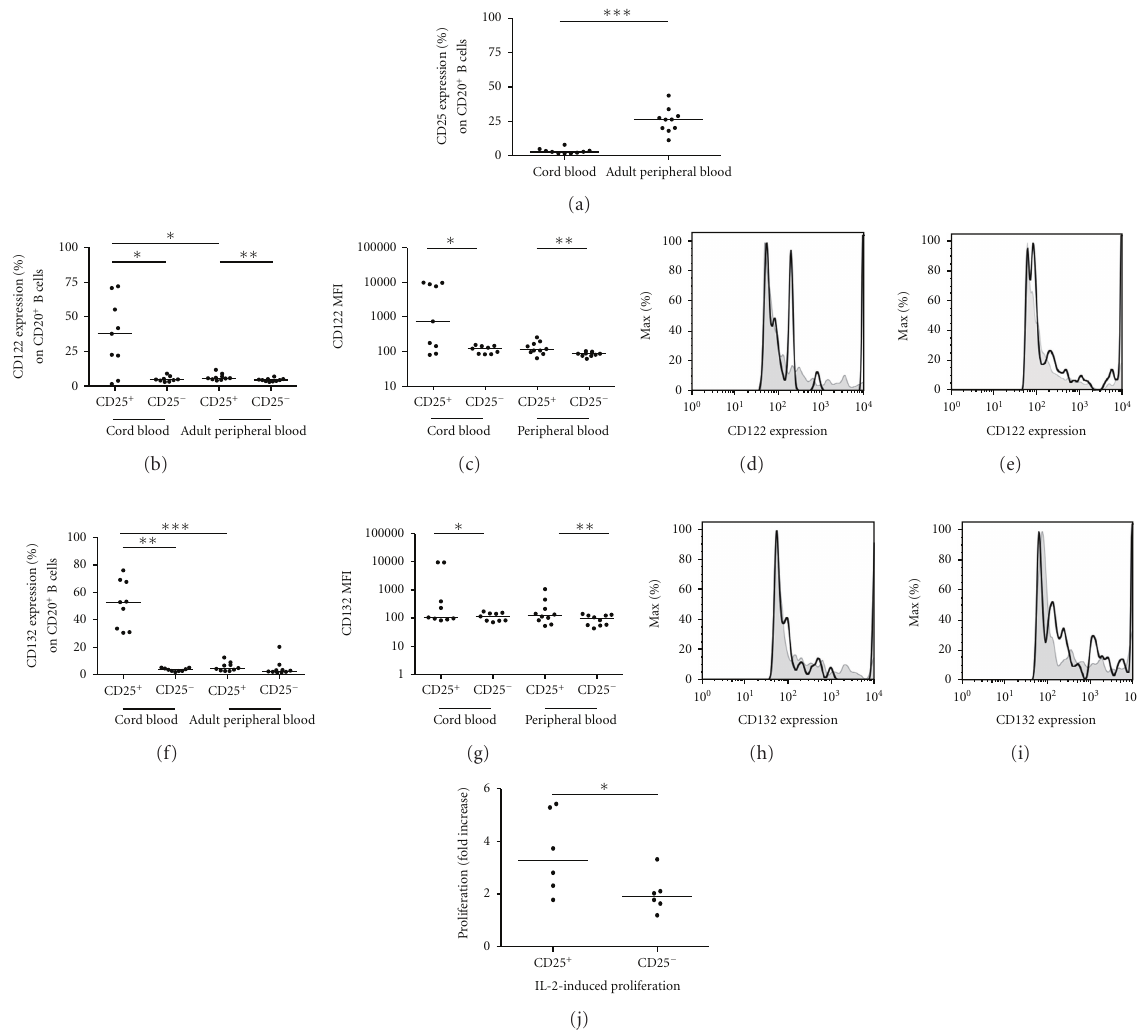
Figure 1: Expression and functional evaluation of the IL-2R on cord blood and adult CD20 + B cells . From freshly isolated cord blood ( N = 10) or adult blood, mononuclear cells ( N = 10) were isolated by density gradient centrifugation. Cells were stained for 3-colour flow cytometry analysis using a combination of CD20, CD25, CD122, or CD132. (a) shows the CD25 expression on CD20 + cells isolated from cord blood or adult blood. In (b), the CD122 expression and in (f) the CD132 expression are analysed on CD25 + and CD25 − CD20 + B cells isolated from cord blood or adult blood. In (c) the median intensity of CD122 and in (g) the median intensity of CD132 are shown on CD25 + and CD25 − CD20 + B cells isolated from cord blood or adult blood. (d) and (h) show a representative histogram of CD122 (d) and CD132 expression on CD25 + and CD25 − cord blood B cells. Black line indicates CD25 + and filled histogram represent CD25 − cord blood B cells. (e) and (i) show a representative histogram of CD122 (d) and CD132 expression on CD25 + and CD25 − adult B cells. Black line indicates CD25 + and filled histogram represent CD25 − adult B cells. Finally, in (j), the proliferation of 3 H-thymidine labelled sorted CD25 + and CD25 − CD20 + B cells isolated from cord blood ( N = 6) is shown following 96 h of stimulation with 25U rh-IL-2. Line in boxes represents median. Statistical evaluation was performed using the parametric unpaired t -test when comparing results from cord blood versus results from adult blood, whereas when comparing results within each group, the paired t -test was used. ∗ P ≤ 0 . 01, ∗∗ P ≤ 0 . 001, and ∗∗∗ P ≤ 0 .